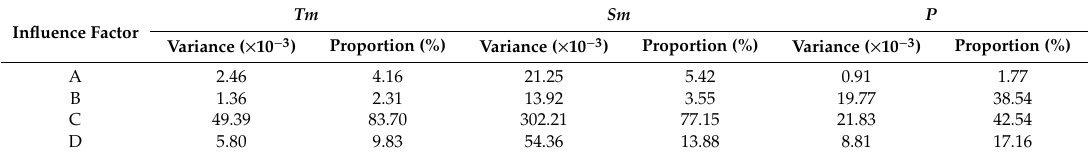
Table 9. Variances of each influence factor and its proportion.